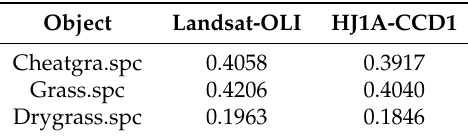
Table 5. The Production Suitability Index (PSI) of Cheatgra.spc, Grass.spc and